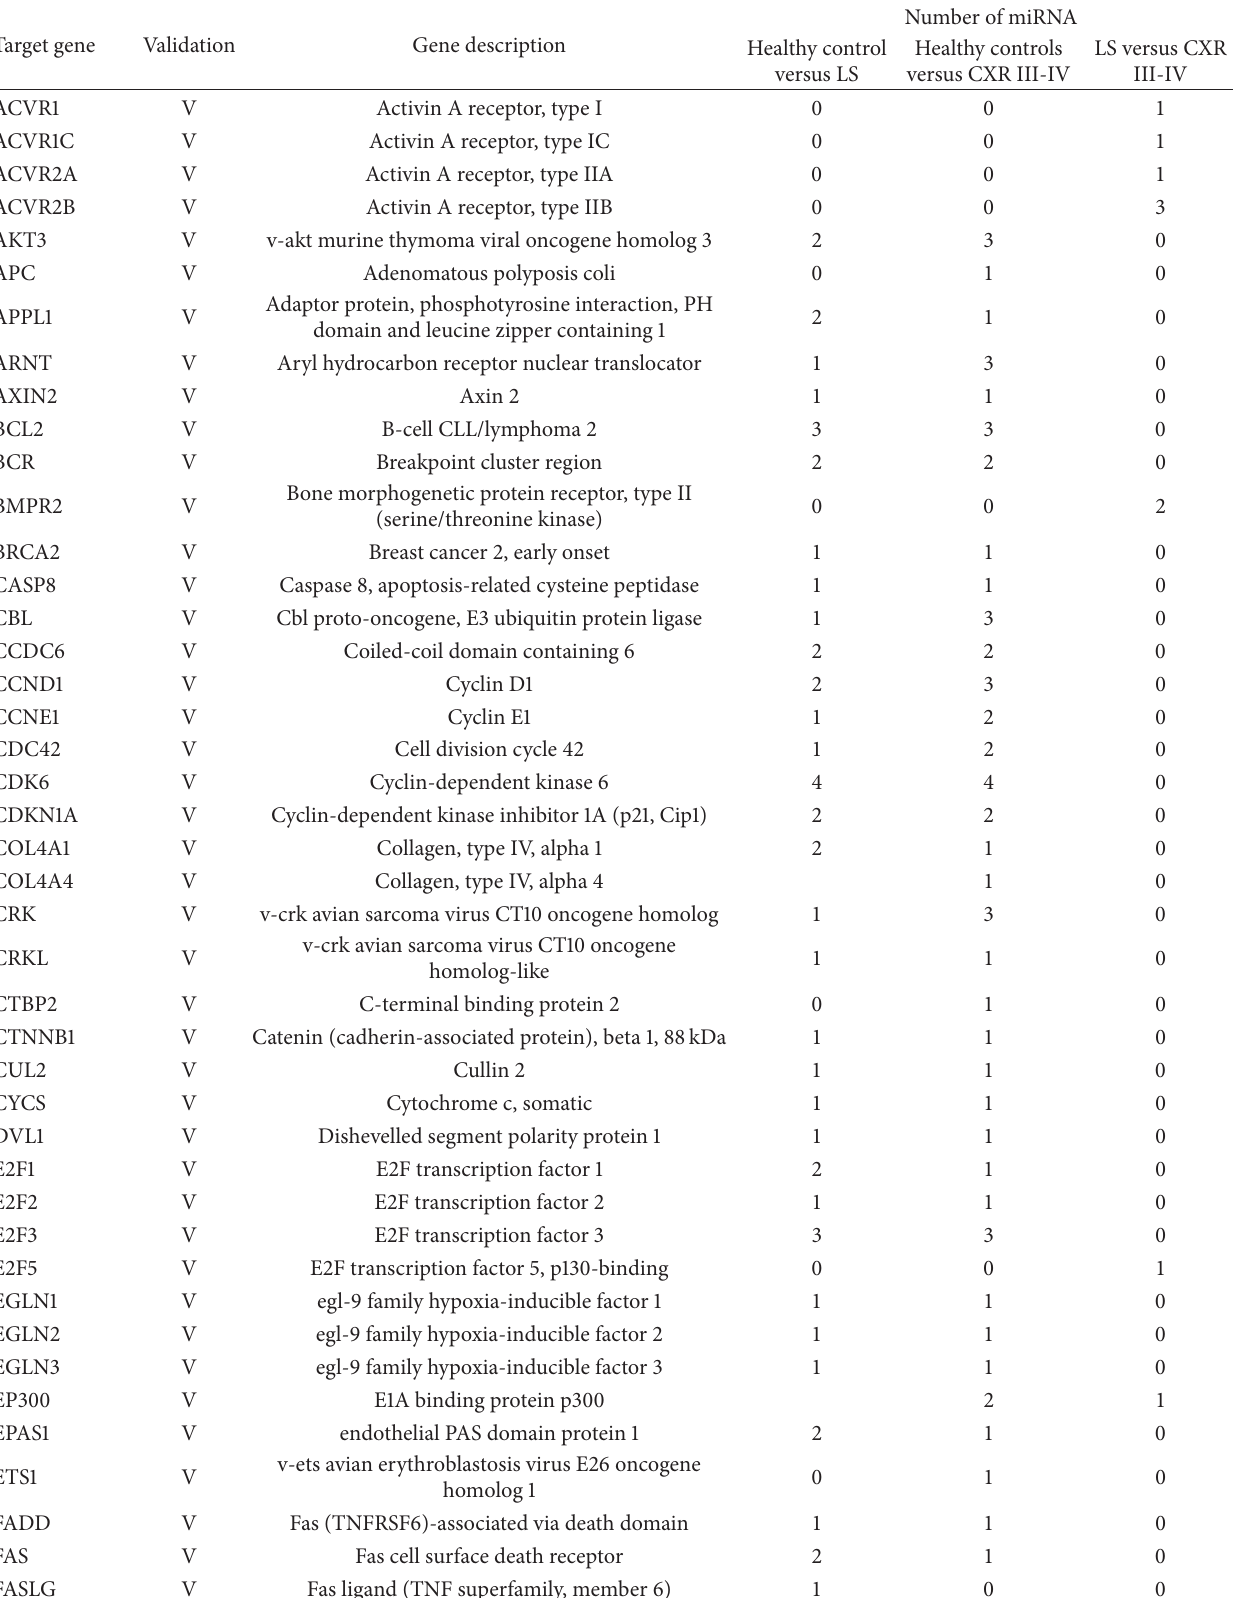
Table 3: The target genes that are predicted to be modulated by the dysregulated miRNAs in our patients with sarcoidosis according to